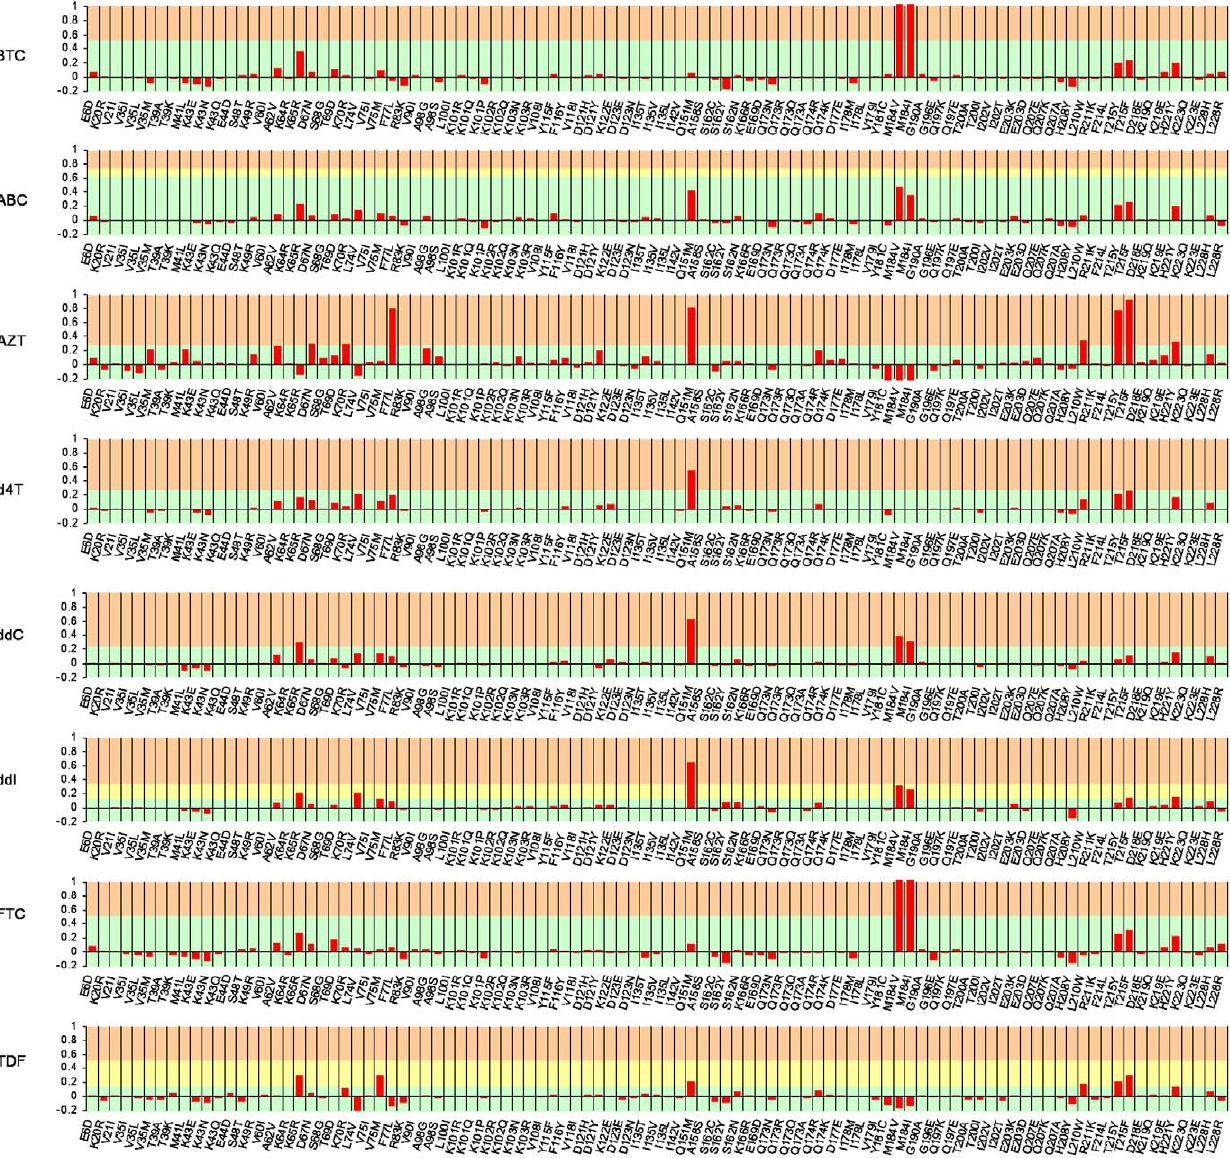
Figure 2. Effects of amino acid mutations on NRTI susceptibility. Illustrated are the changes in susceptibility to the eight NRTIs on single amino acid mutations in the wild type HIV-1 RT. Shown are the decimal logarithms of the fold-changes in susceptibility calculated from the proteochemometric model ( Model-3 ). The green, yellow, and red areas in each panel represent susceptibilities falling, respectively, below the lower cut-off, between the lower and upper cut-off, and above the upper cut-off levels for resistance; the cut-offs being as defined by the PhenoSense assay documentation [http://www.monogramhiv.com/phenosense_report.aspx]. For some NRTIs, only one cut-off value is defined (shown in the figure by omission of the yellow zone); the cut-off for ddC (a discontinued NRTI) is set arbitrarily for illustration purposes